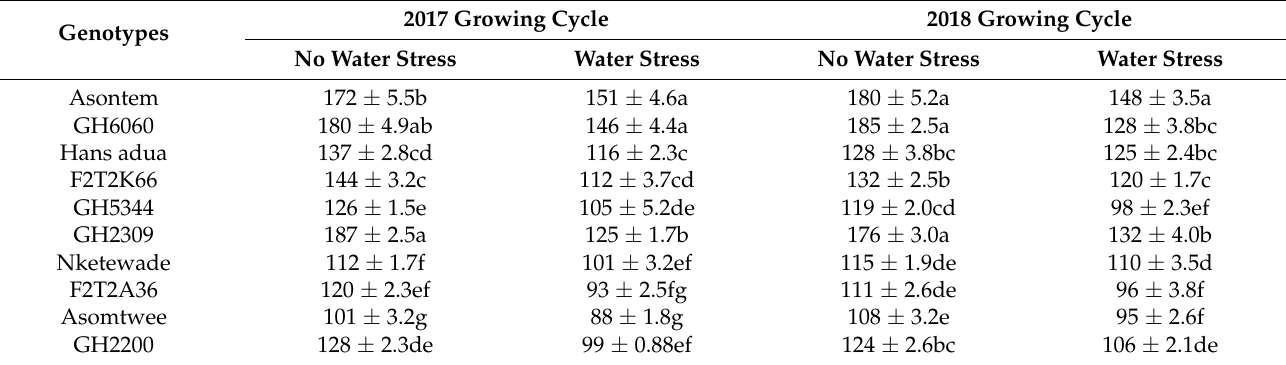
Table 5. Biomass (kg DM ha − 1 ) of cowpea genotypes after imposition of water stress during vegetative stage for 2017 and 2018 growing cycles. Values showing the same letters indicate no significant differences between genotypes within individual water treatments at p ≤